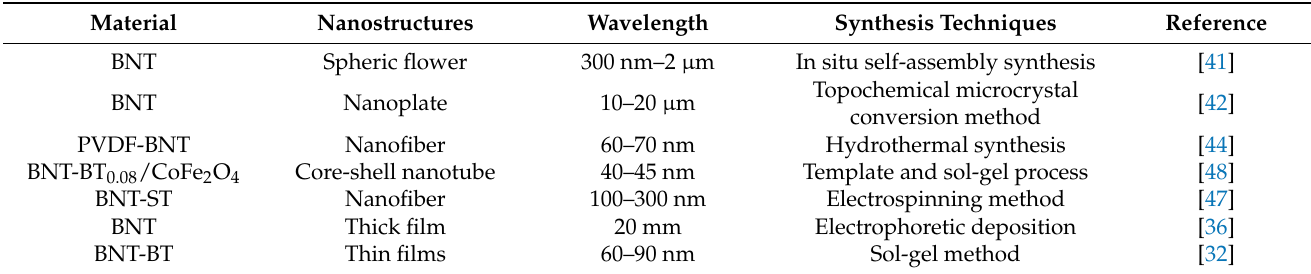
Table 1. Summary of morphology and synthesis methods of BNT-based